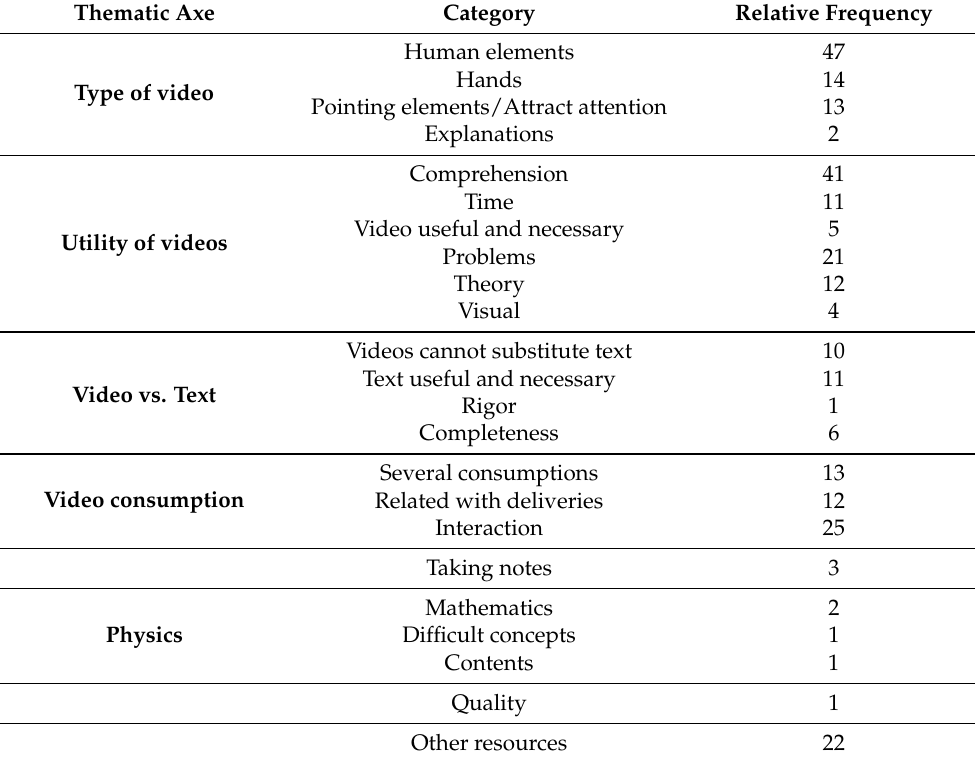
Table 3. Proposed categories related to the groups of the conditional/causal matrix and with the relative frequency of